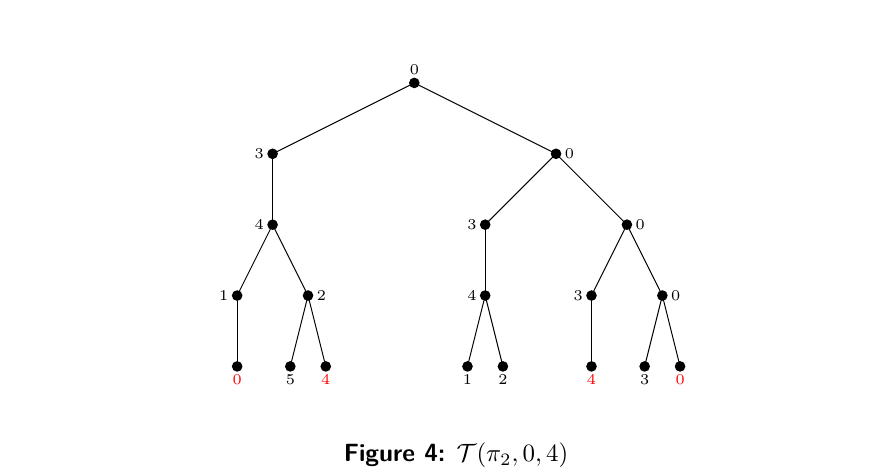
Figure 4: T ( π 2 , 0 , 4)